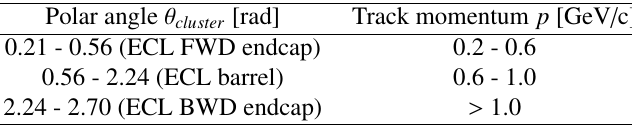
Table 2. The polar angle and momentum ranges that define the 9 independent categories where BDTs are